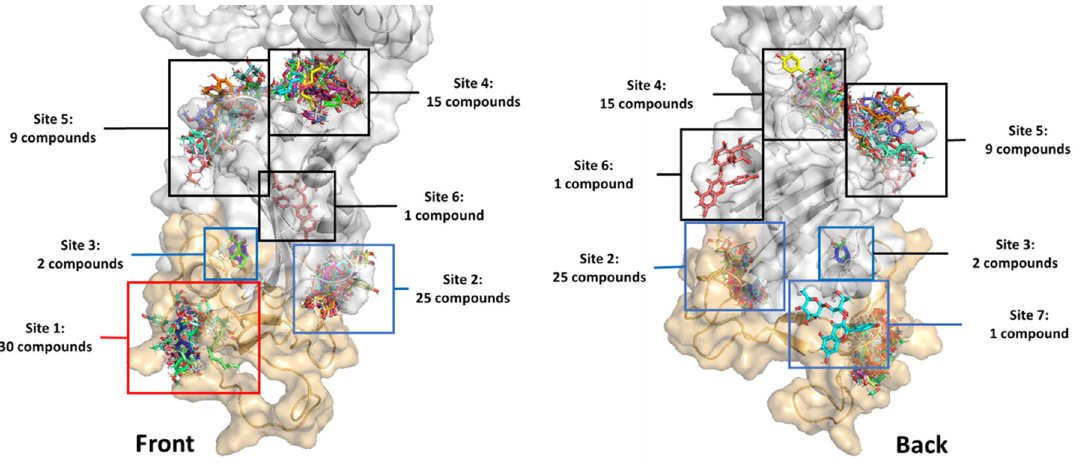
Figure 1. The binding sites of 83 in-house library compounds from Dendrobium sp. The orange surface is the receptor-binding motif (RBM) of amino acid residues 437–508. Table 1. Docking result of the top-ranking compounds from Dendrobium sp. against the SARS-CoV- 2 spike protein .